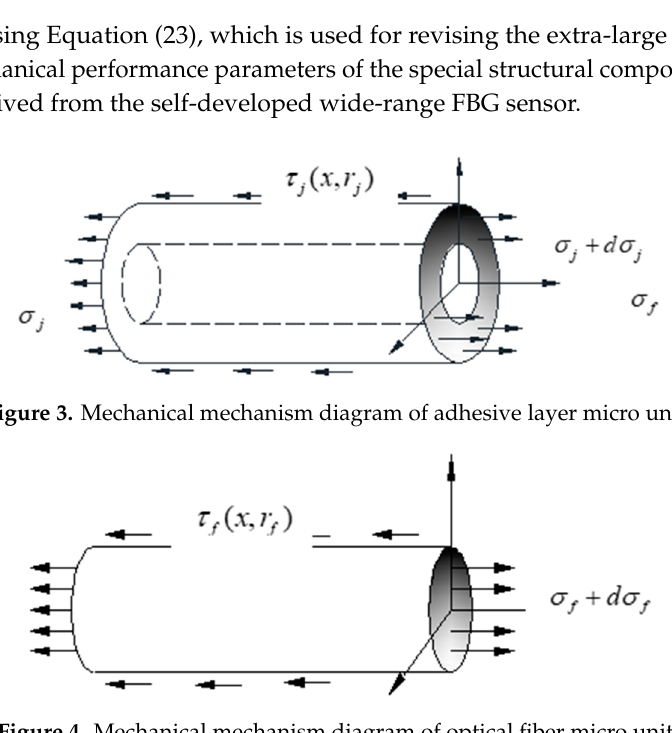
Figure 4. Mechanical mechanism diagram of optical fiber micro unit.